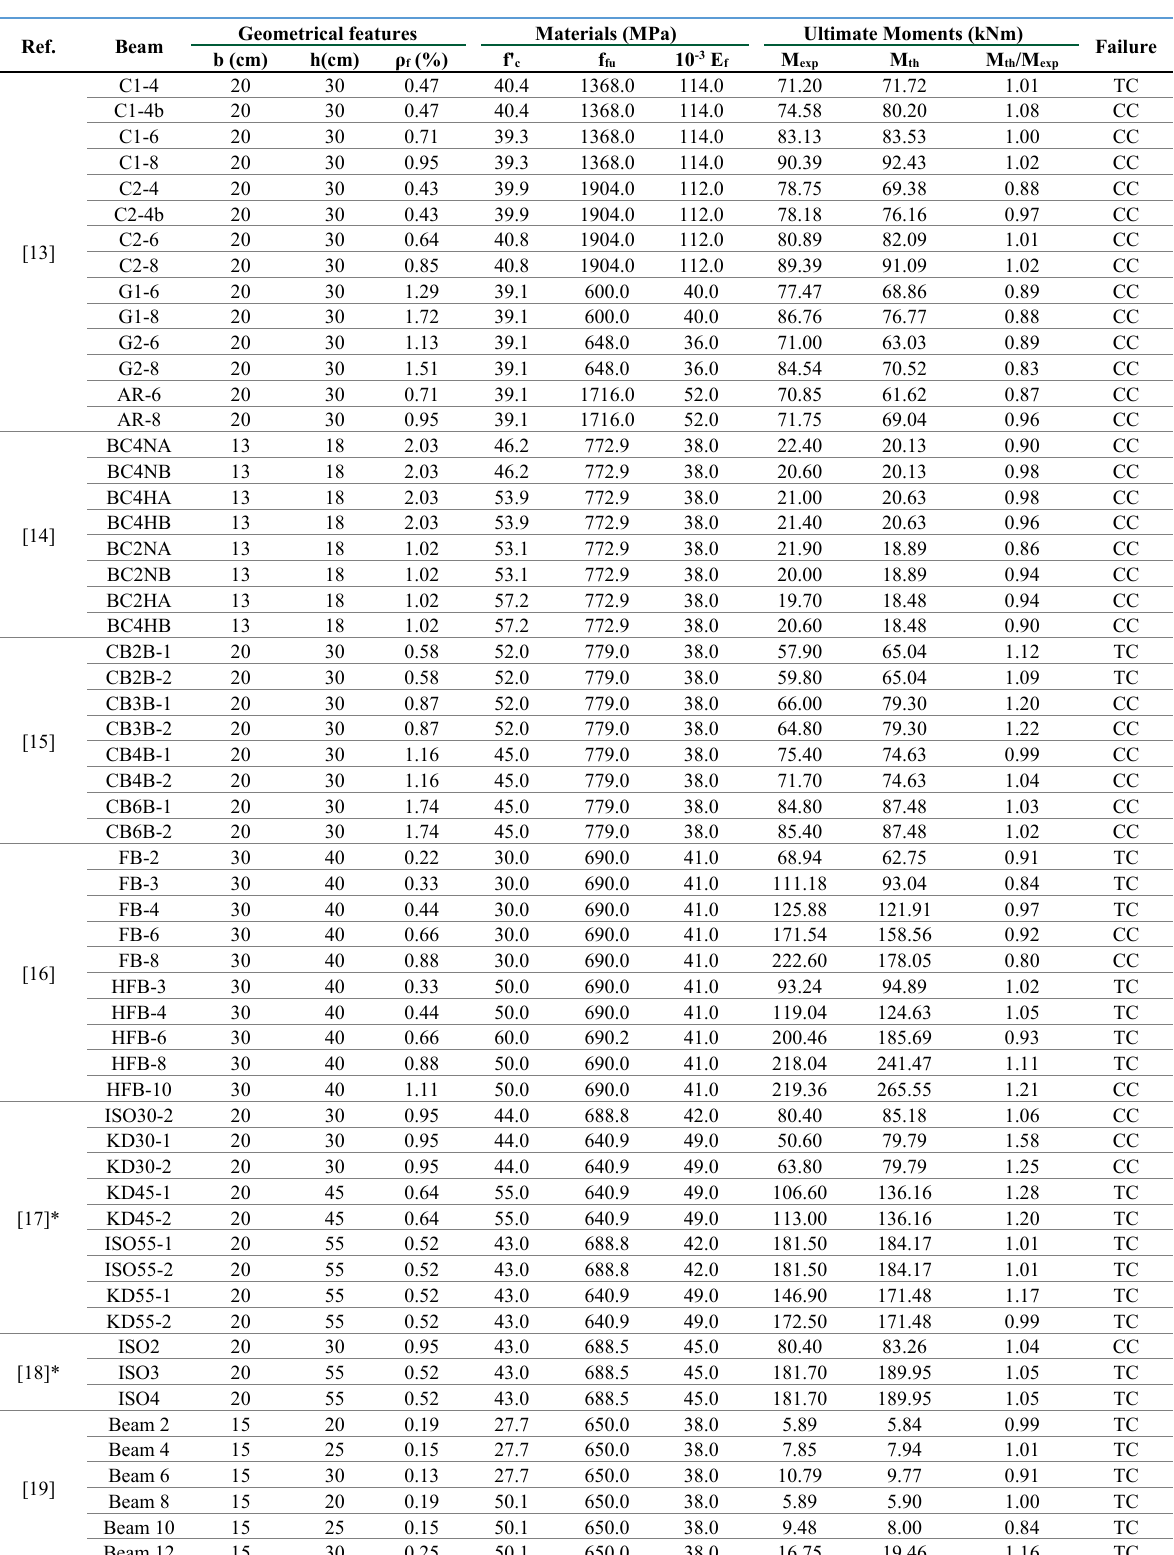
Table 1 - Comparison between experimental and predicted flexural capacities